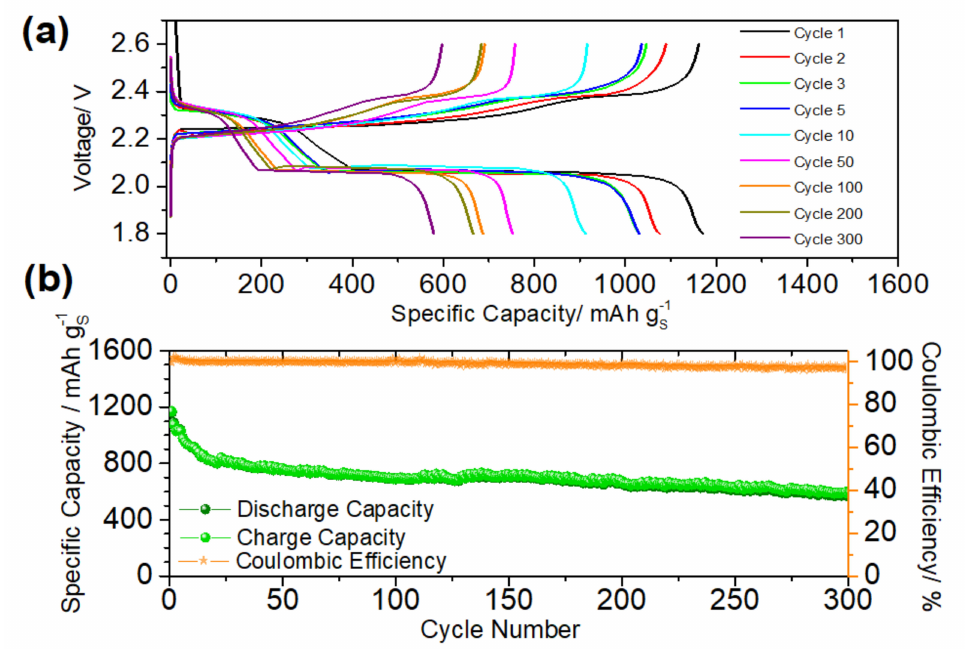
Figure 3. ( a ) Galvanostatic charge / discharge curves at di ff erent cycles recorded at C / 10. ( b ) Variation in the discharge capacity and coulombic e ffi ciency as a function of the number of cycles.